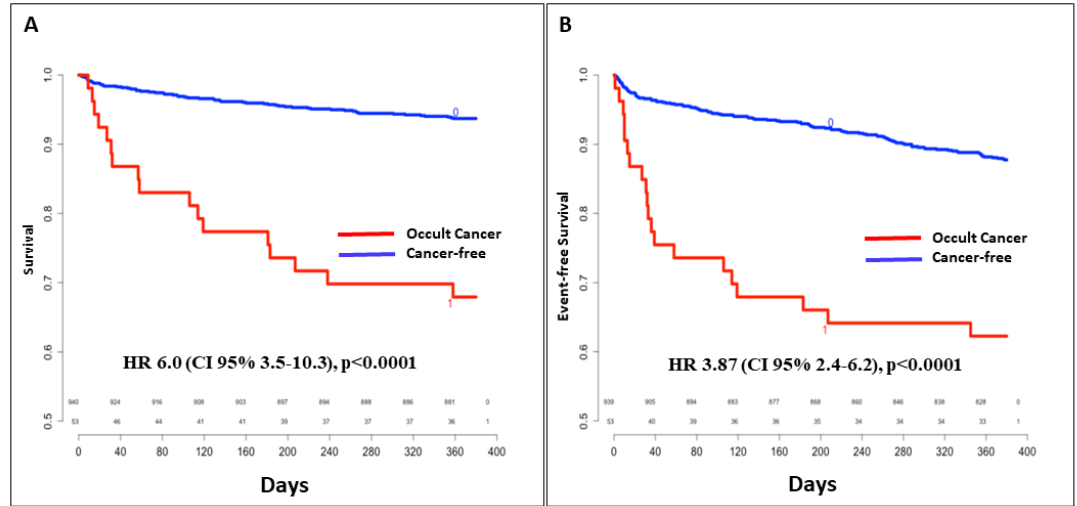
Figure 2. Overall survival ( A ) and event-free (VTE recurrence, major bleeding and all-cause death) survival ( B ) according to occult cancer status. CI: confidence interval; HR: hazard ratio; VTE: venous thromboembolism